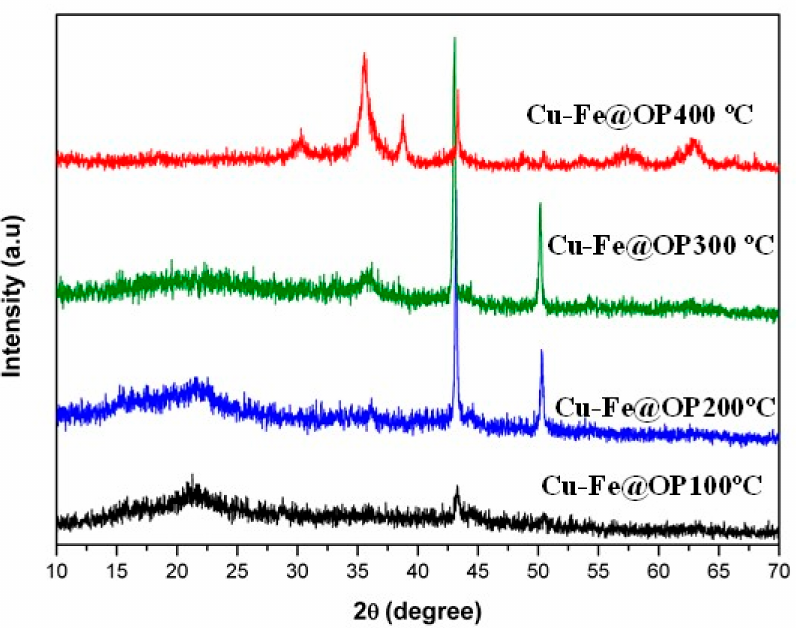
Figure 1. X-ray diffraction (XRD) patterns of Cu-Fe@OP100 ◦ C, Cu-Fe@OP200 ◦ C, Cu-Fe@OP300 ◦ C, and Cu-Fe@OP400 ◦ C samples.